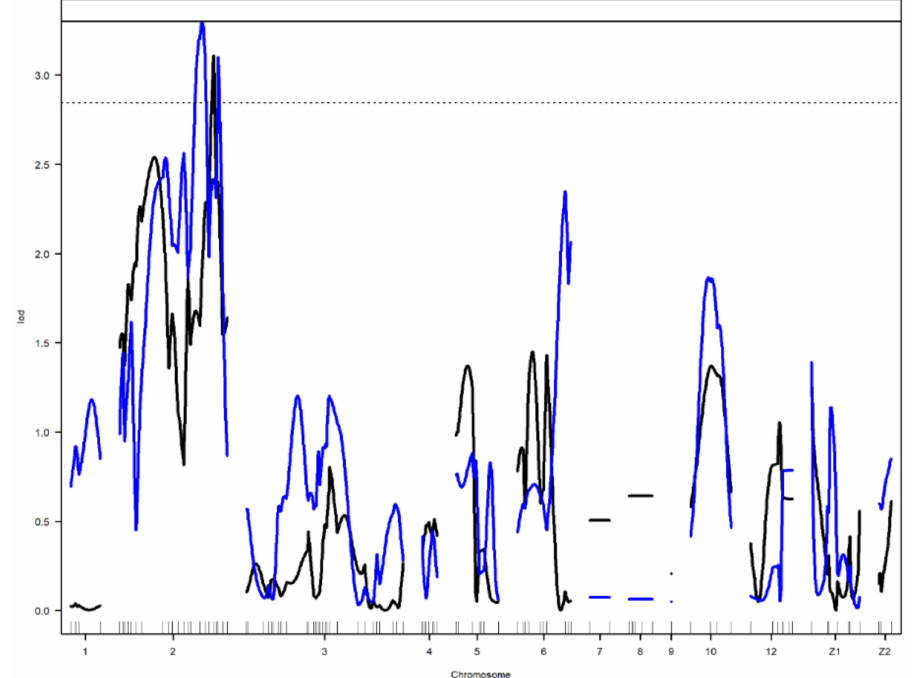
Figure 2. Genome-wide LOD plot of detected QTL for age at first egg (blue) and yolk color- yellowness 2 (black) on chromosome 2. The horizontal lines show the genome-wide significance at 5% (straight line) and suggestive threshold at 10% (dotted line) levels.